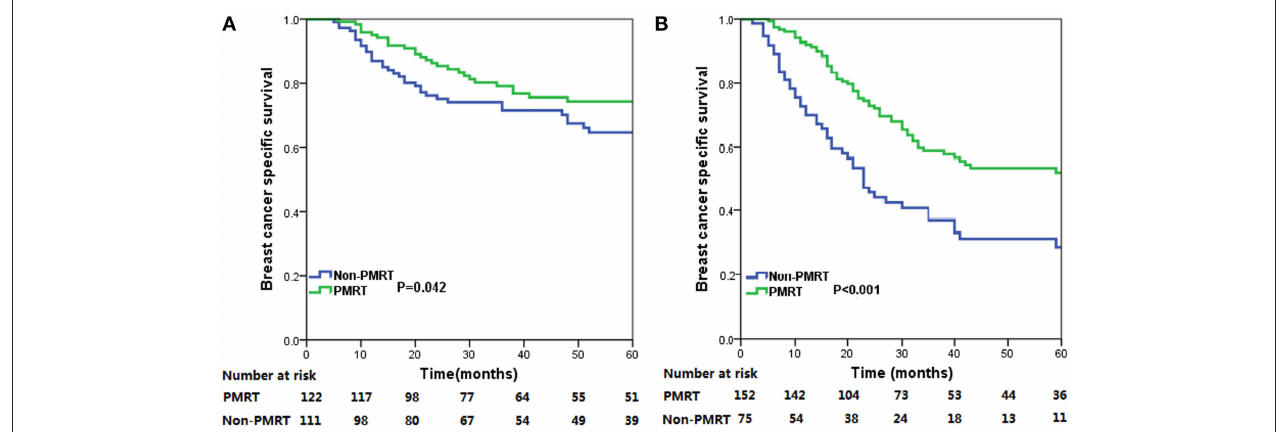
FIGURE 2 | Breast cancer specific survival (BCSS) curves for all patients with metaplastic breast cancer (MBC) with and without post-mastectomy radiotherapy (PMRT) in the intermediate-risk (A) and high-risk (B) groups.